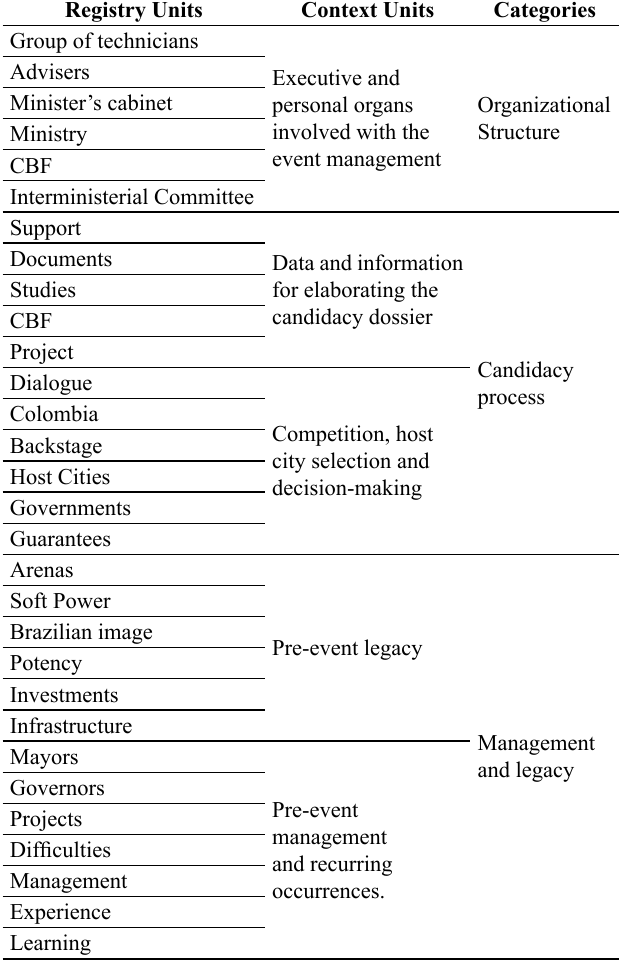
Table 2. Analysis categories